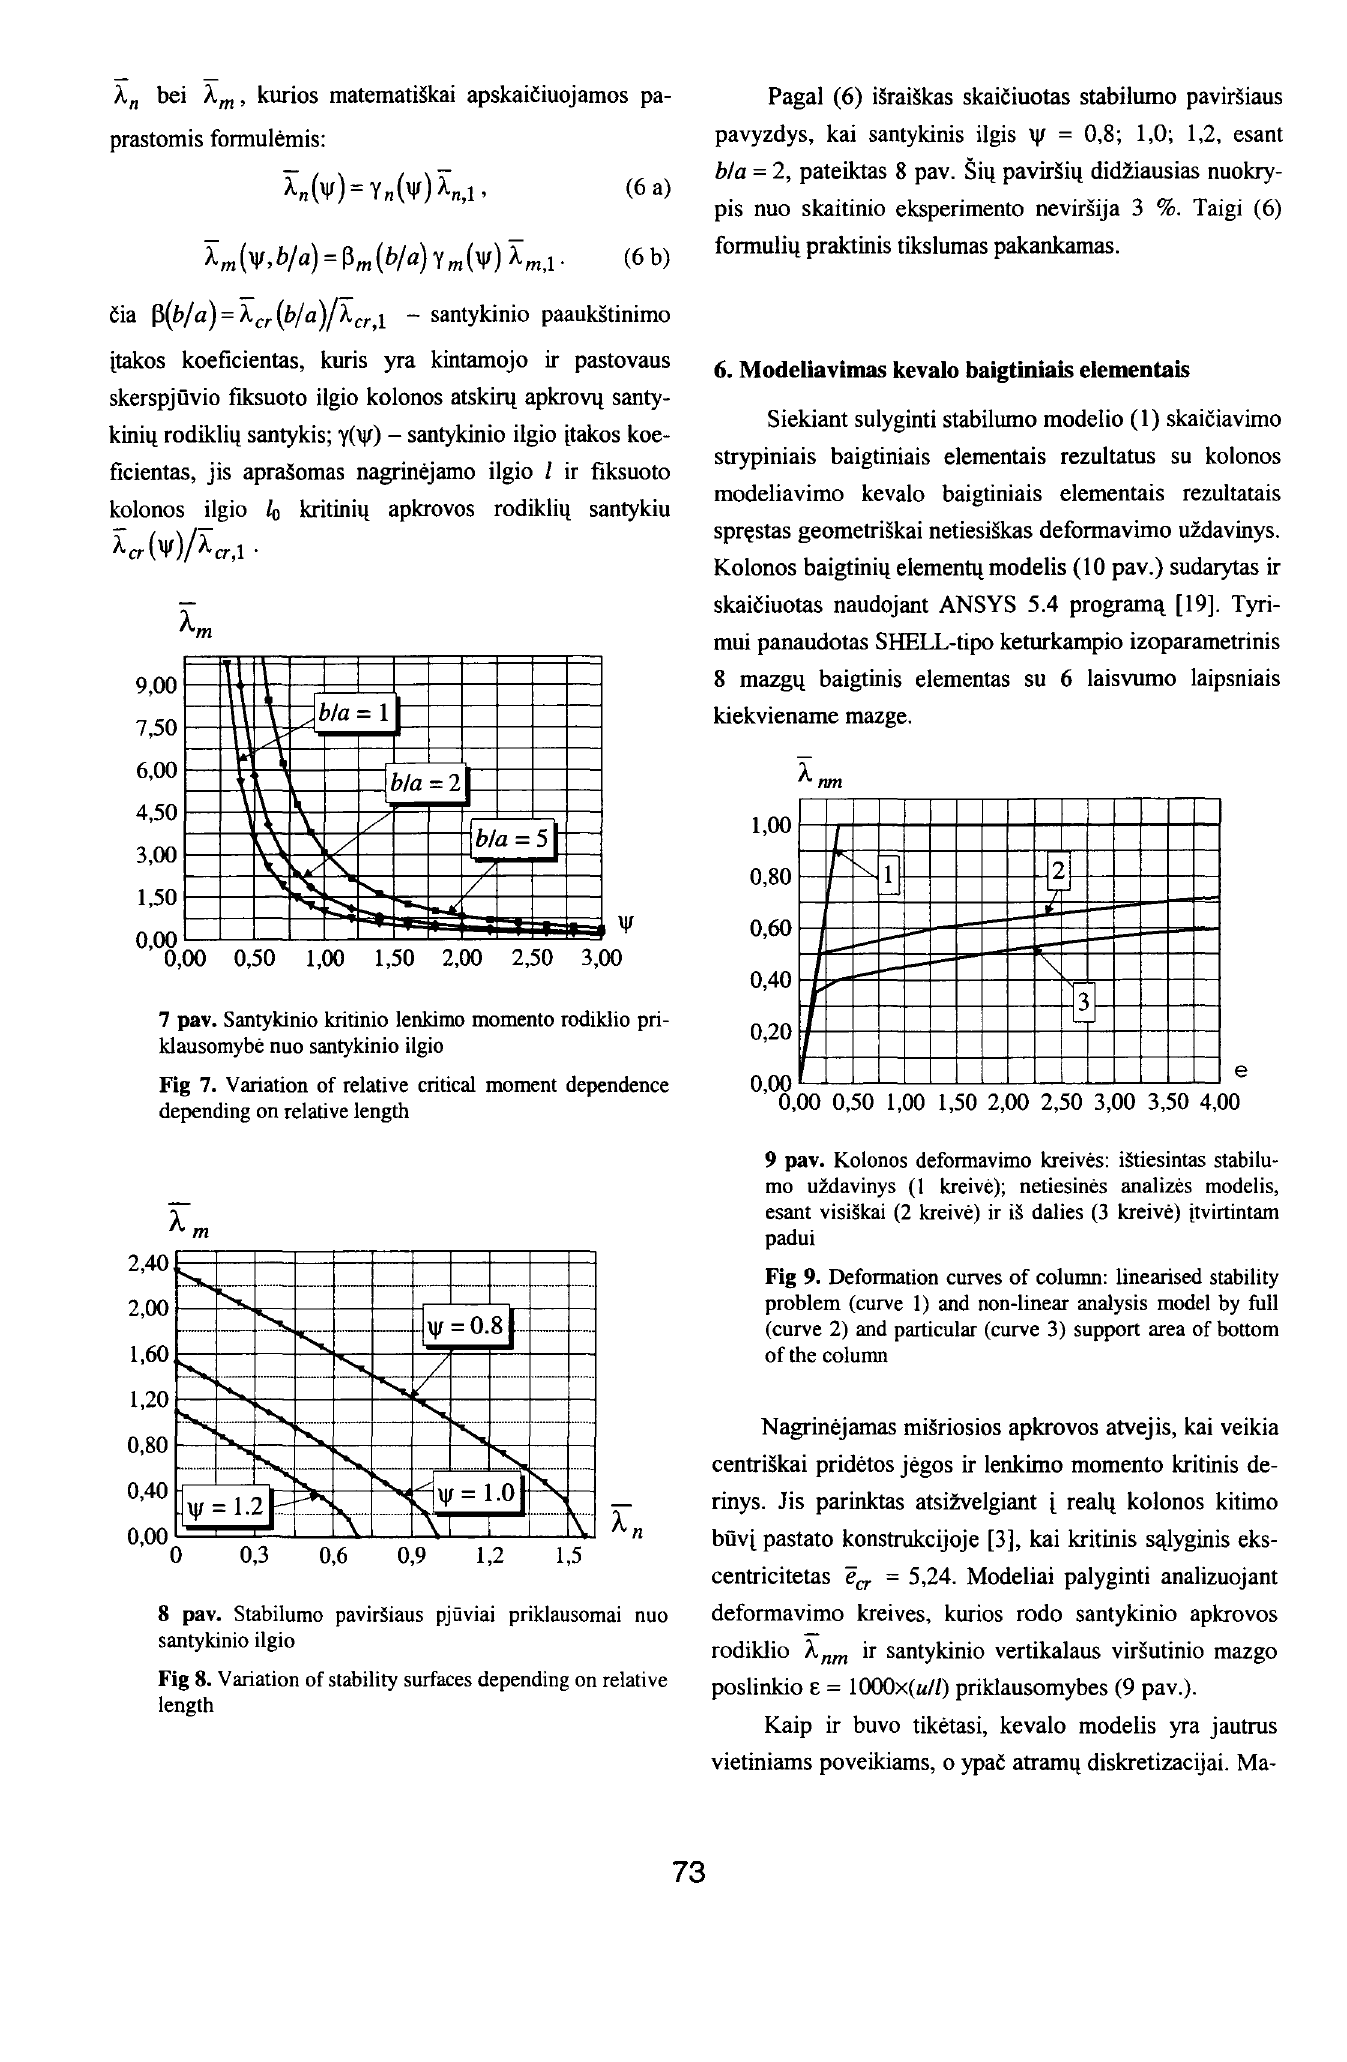
Fig 8. Variation of stability surfaces depending on relative length